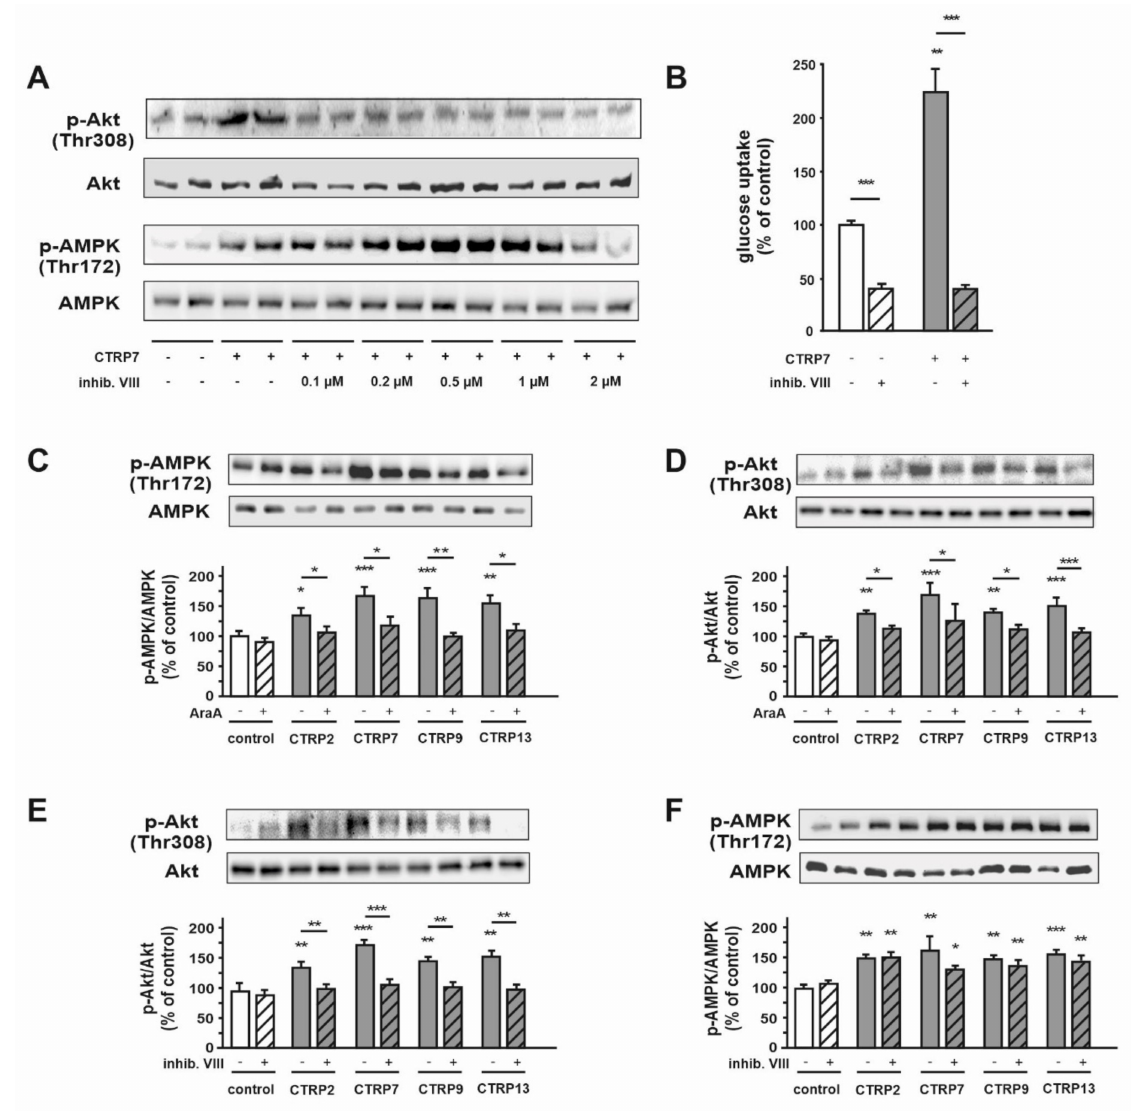
Figure 3. Role of AMPK and Akt on CTRP-induced effects in adult rat cardiomyocytes. ( A ) Cells were treated with CTRP7 for 10 min after preincubation with the Akt inhibitor VIII at the indicated concentrations for 30 min. Phosphorylation of Akt and AMPK were determined by Western Blotting. Total AMPK or total Akt served as loading control. Data are mean ± SEM from 5 independent experiments with 2 biological replicates, each. ( B ) Glucose uptake was measured after preincubation with the Akt inhibitor VIII (2 µ M) for 30 min followed by CTRP7 for 10 min. Data are mean ± SEM of 5 independent experiments with 2 biological replicates, each. * p < 0.05, ** p < 0.01, *** p < 0.001 vs. untreated control, unless otherwise indicated. Phosphorylation of AMPK and Akt was investigated after preincubation with ( C , D ) AraA (500 µ M) or ( E , F ) Akt inhibitor VIII (0.1 µ M) for 30 min, followed by 10 min treatment with CTRP2, CTRP7, CTRP9 or CTRP13. Total AMPK or total Akt served as loading control. Data are mean ± SEM from 5 independent experiments with 2 biological replicates,